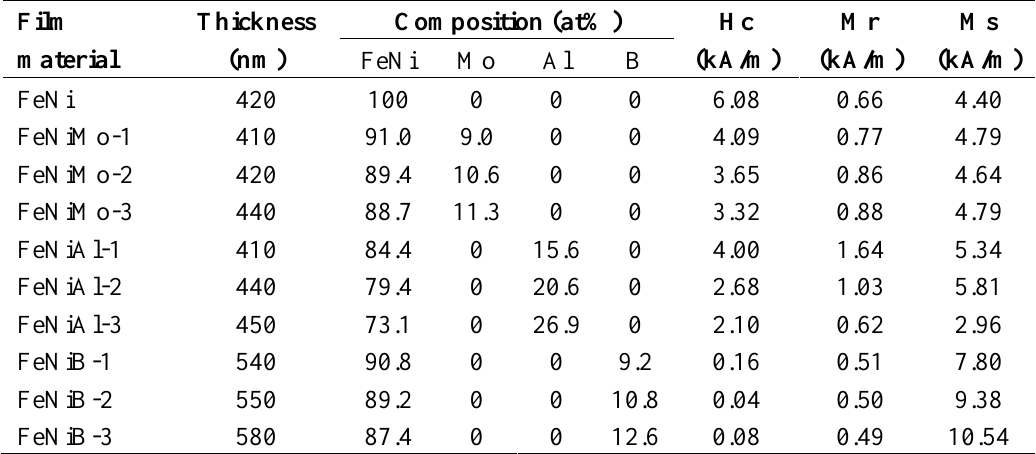
Table 2. Thin films’ thickness, composition and magnetic